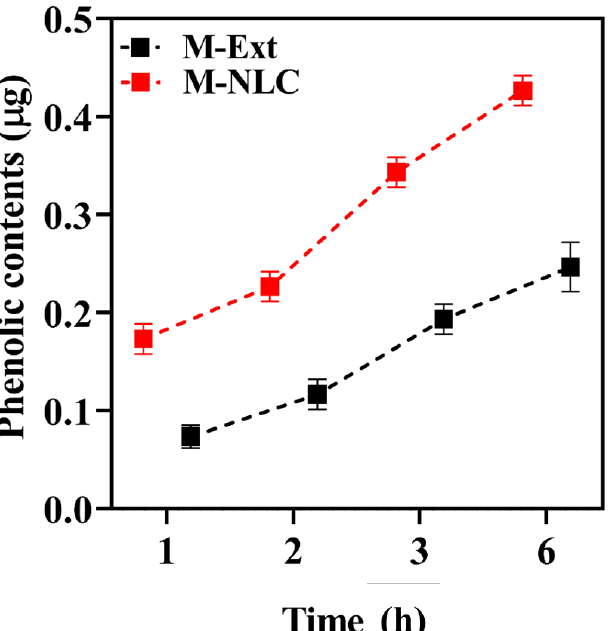
Figure 8. In vitro permeation study. HaCaT cells monolayer was used to determine the rate of permeation of M-NLC and M-Ext. Data shown as means ± SD ( n = 3).